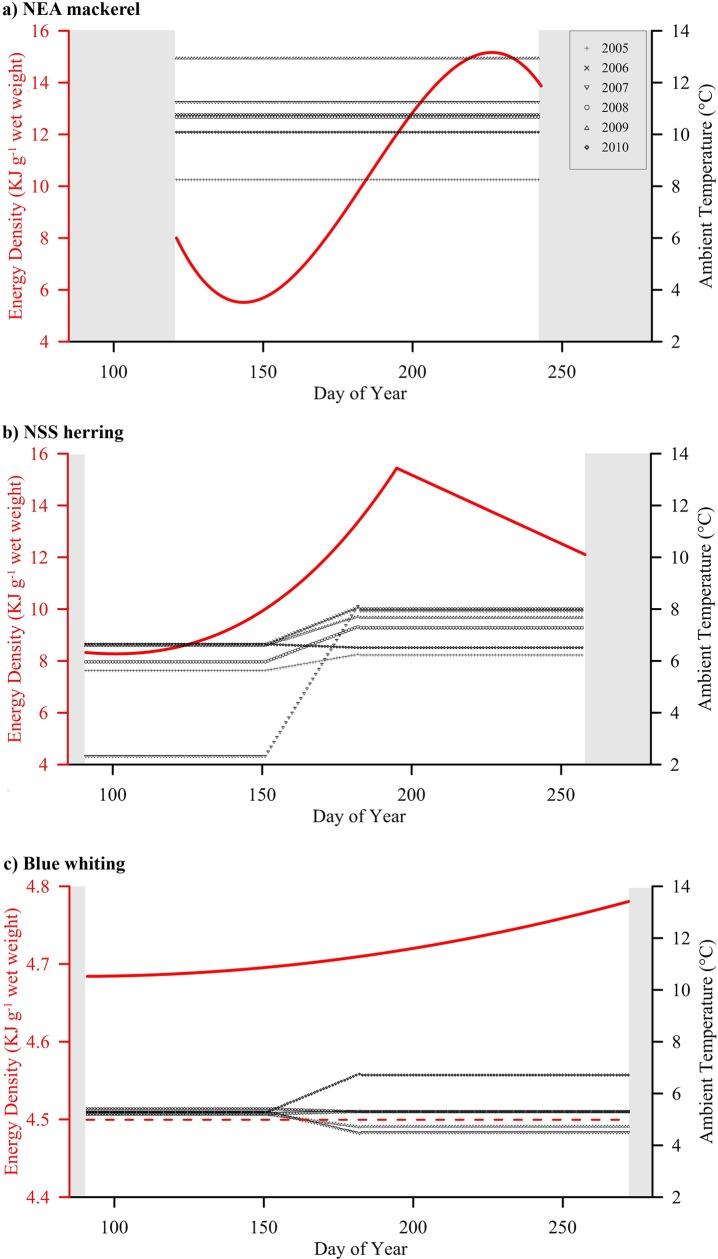
Daily energy density averages (red lines and left Y axes, in kJ g-1
wet weight) and ambient temperature (black symbol-lines and right Y axes) for (a) NEA mackerel, (b) NSS herring (energy density as in Varpe et al. [11]) and (c) blue whiting. White background represents the feeding period assumed for each species. The blue whiting plot (c) represents the assumed fixed value for cod (horizontal red dotted line) and the accumulated energy in liver (E.Lv = 0.0028t2 − 0.4842t + 205.02; R2 = 0.997); this equation was extracted from our model observations (note the different scale in left Y axis). See Table 5 for further details about equations used in the bioenergetics model.